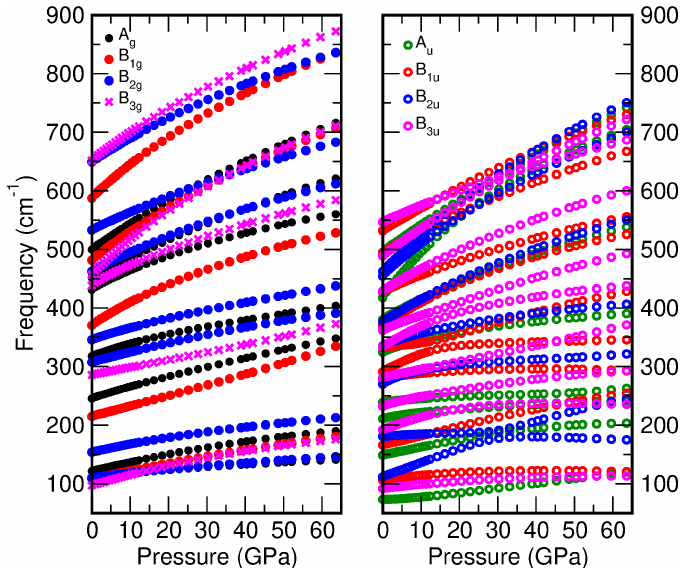
Figure 10. ( left ) Pressure dependence of the calculated Raman-active modes of DyScO 3 perovskite; ( right ) idem for the infrared and silent